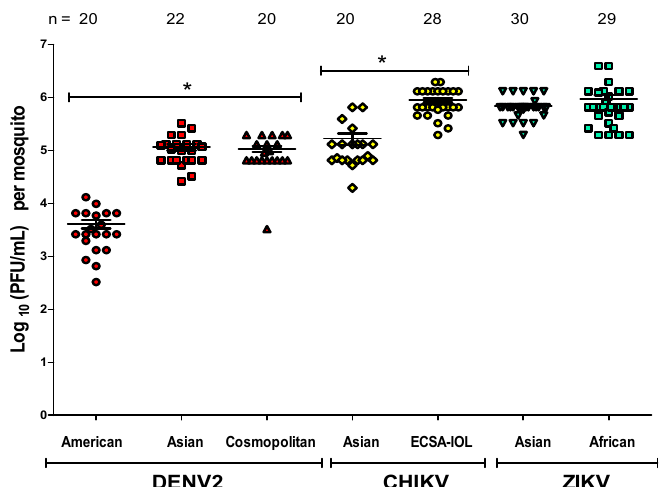
Figure 4. Titer of Mapastepec Aedes aegypti mosquitoes 7 days after intrathoracically injecting with 500 plaque forming units (PFU) of virus. Titers were determined by plaque assay in the whole mosquito for each viral strain. Means and 95% confidence intervals are shown. * = p < 0.0001. CHIKV or ZIKV genotypes did not present SGIB, whereas DENV2 genotypes showed low rates of SGIB (Table 1). Specifically, after 7 dpi, 5.5% (38/691), 0.75% (5/667), and 0.59% (4/681) of Ae. aegypti salivary glands were uninfected with the DENV2 Ameri- can, Asian, and Cosmopolitan genotypes, respectively. All salivary glands, on the other hand, were infected with CHIKV or ZIKV. Average viral titer (log 10 (PFU/mL)) per sali- vary gland was calculated for all seven virus genotypes. Means and 95% confidence inter- vals are shown in Figure 5A.